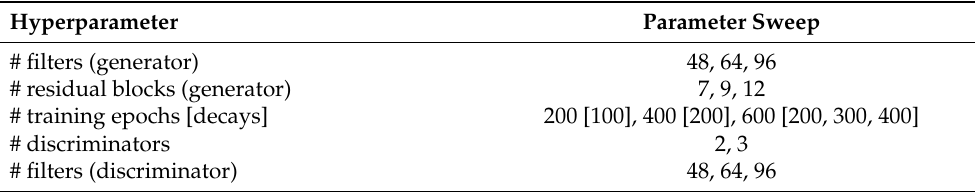
Table 1. Overview of hyperparameters analyzed in this